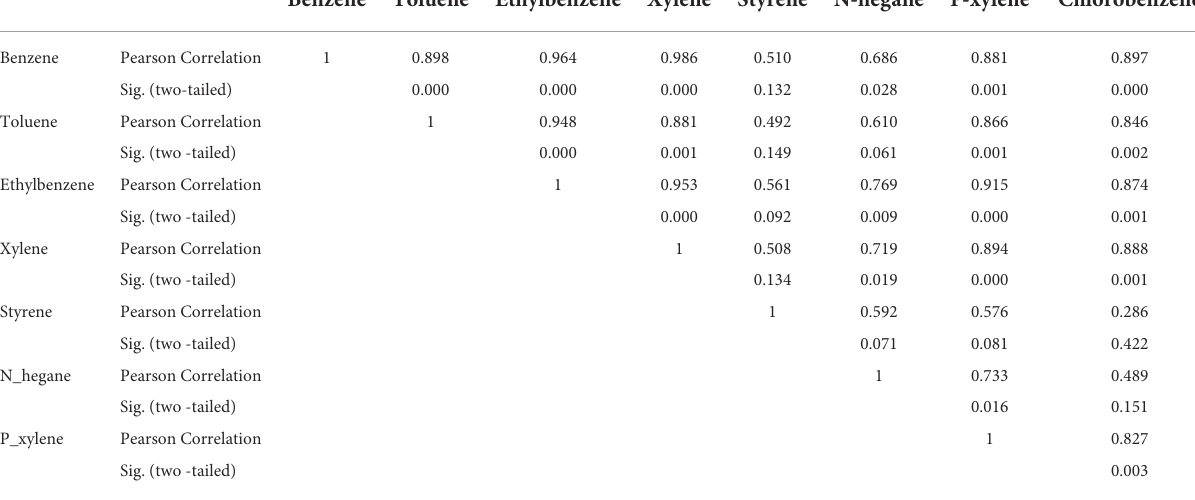
TABLE 7 Results of correlation analysis between the concentrations of volatile organic compounds in the ROP unit of the